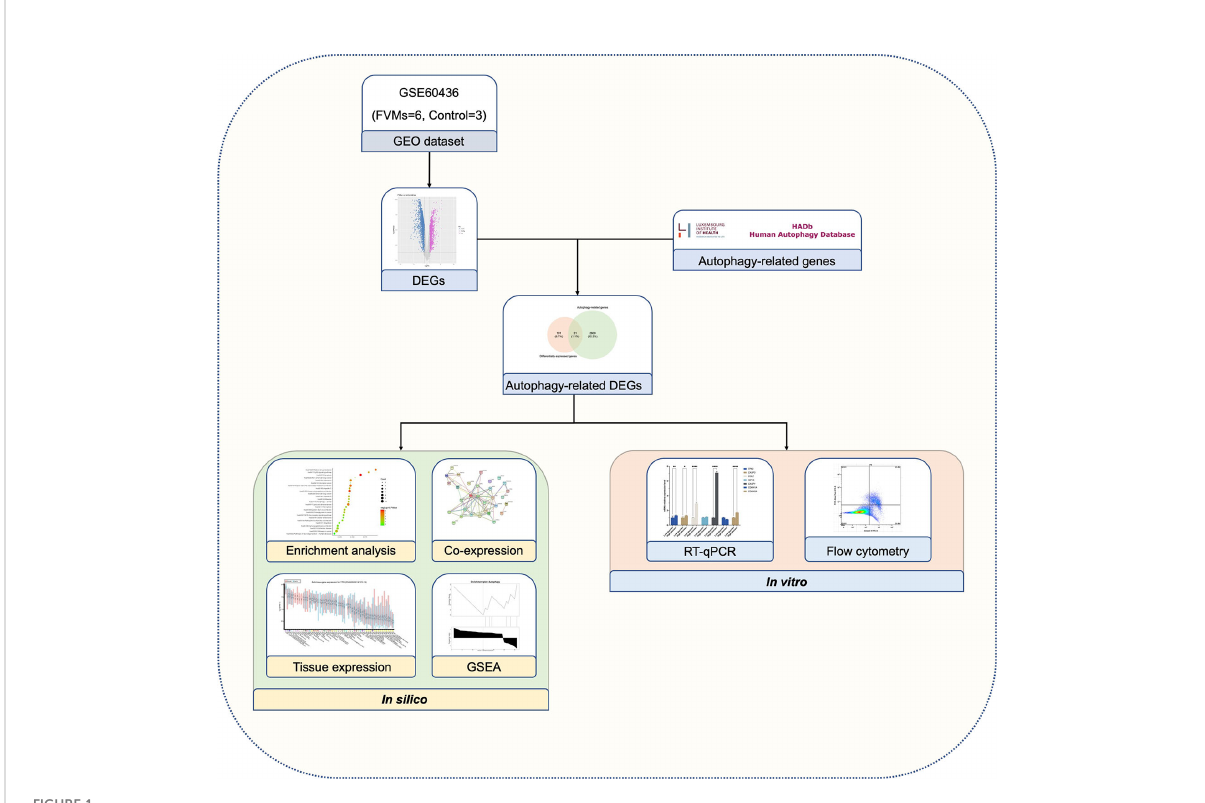
FIGURE 1 Schematic overview of the study